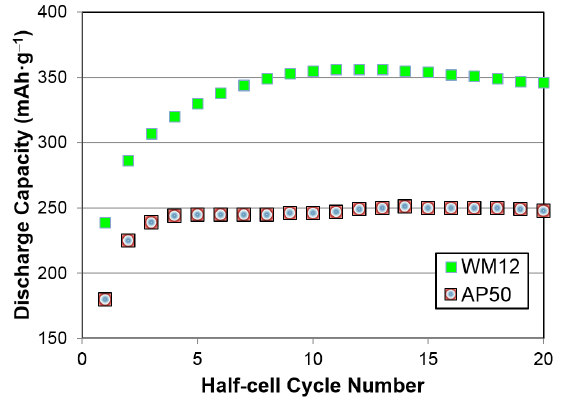
Figure 3. Half-cell capacities obtained at a discharge current of 30 mA·g − 1 for WM12 and AP50. Batteries 2017 , 2 , 38